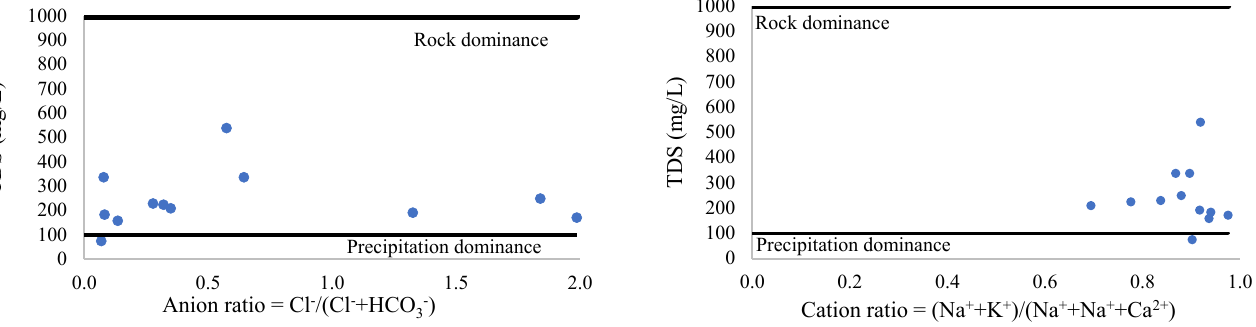
Figure 3. Gibbs diagrams indicating anion and cation ratio for all water samples (1–12).